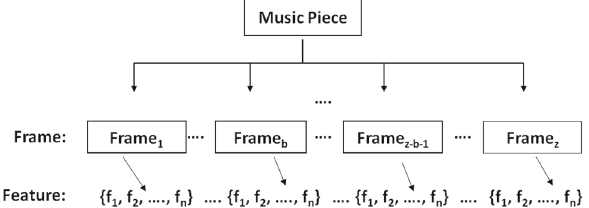
Fig. 5 Structure of MFCCs